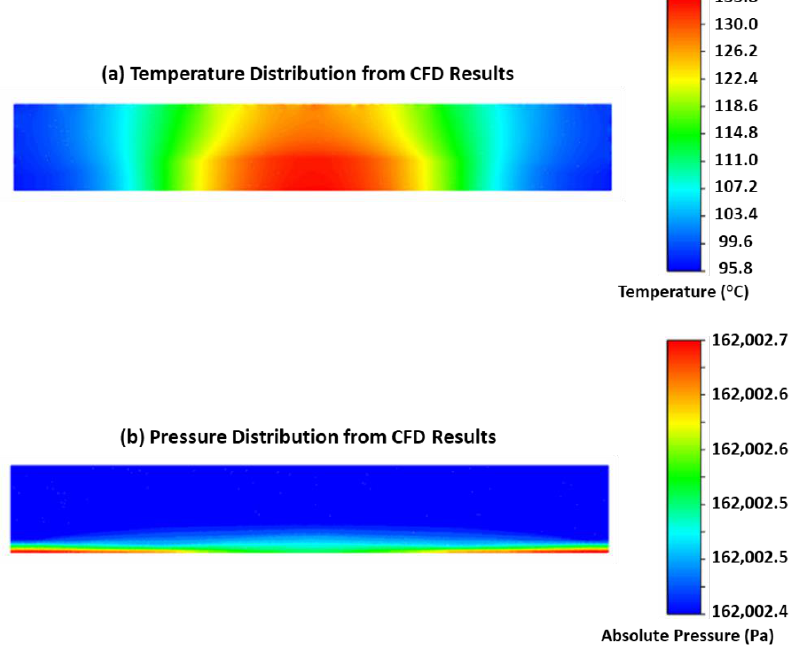
Figure 3. Two-dimensional sensor cavity simulation results of ( a ) temperature and ( b ) absolute total pressure.